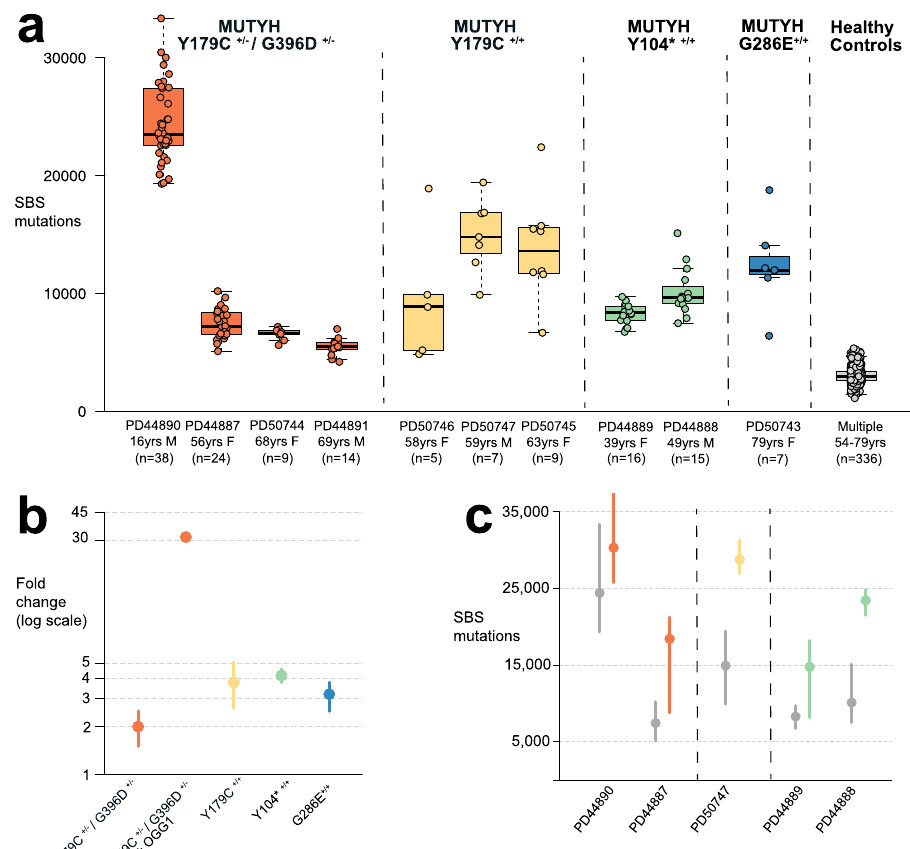
Fig. 1 Somatic mutation burdens in cells with MUTYH mutations. Elevated mutation burdens in normal intestinal cells with MUTYH mutations. a Genome- wide single base substitution (SBS) mutation burden of individual intestinal crypts ( n = 144 biologically independent samples) grouped according to patient. Each dot represents an individual intestinal crypt. MUTYH genotypes are displayed separately. Boxplots display median, inter-quartile range (IQR) from 1 st to 3 rd quartiles and whiskers extend from the last quartile to the last data point that is within 1.5x IQR. b Fold-change in SBS rate in intestinal crypts ( n = 144) with MUTYH mutations compared with wild-type controls 3 ( n = 445). Fold changes are represented by the dot, whiskers represent the 95% con fi dence interval (Methods). Dots are coloured according to germline genotype: orange; MUTYH Y179C + / − G396D + / − ( n = 47), MUTYH Y179C + / − G396D + / − & OGG1 ( n = 38), yellow; MUTYH Y179C + / + ( n = 21), green; MUTYH Y104* + / + ( n = 31), blue; MUTYH G286E + / + ( n = 7). c Genome-wide single base substitution burden in histologically normal crypts (grey) and adenoma crypts (orange, yellow and green) arranged by patient and germline mutation. Data was available for 5 individuals who had adenoma glands sequenced. Dot represents the median and whiskers indicate the range from lowest to highest mutation burden per patient. Source data are provided as a Source Data fi